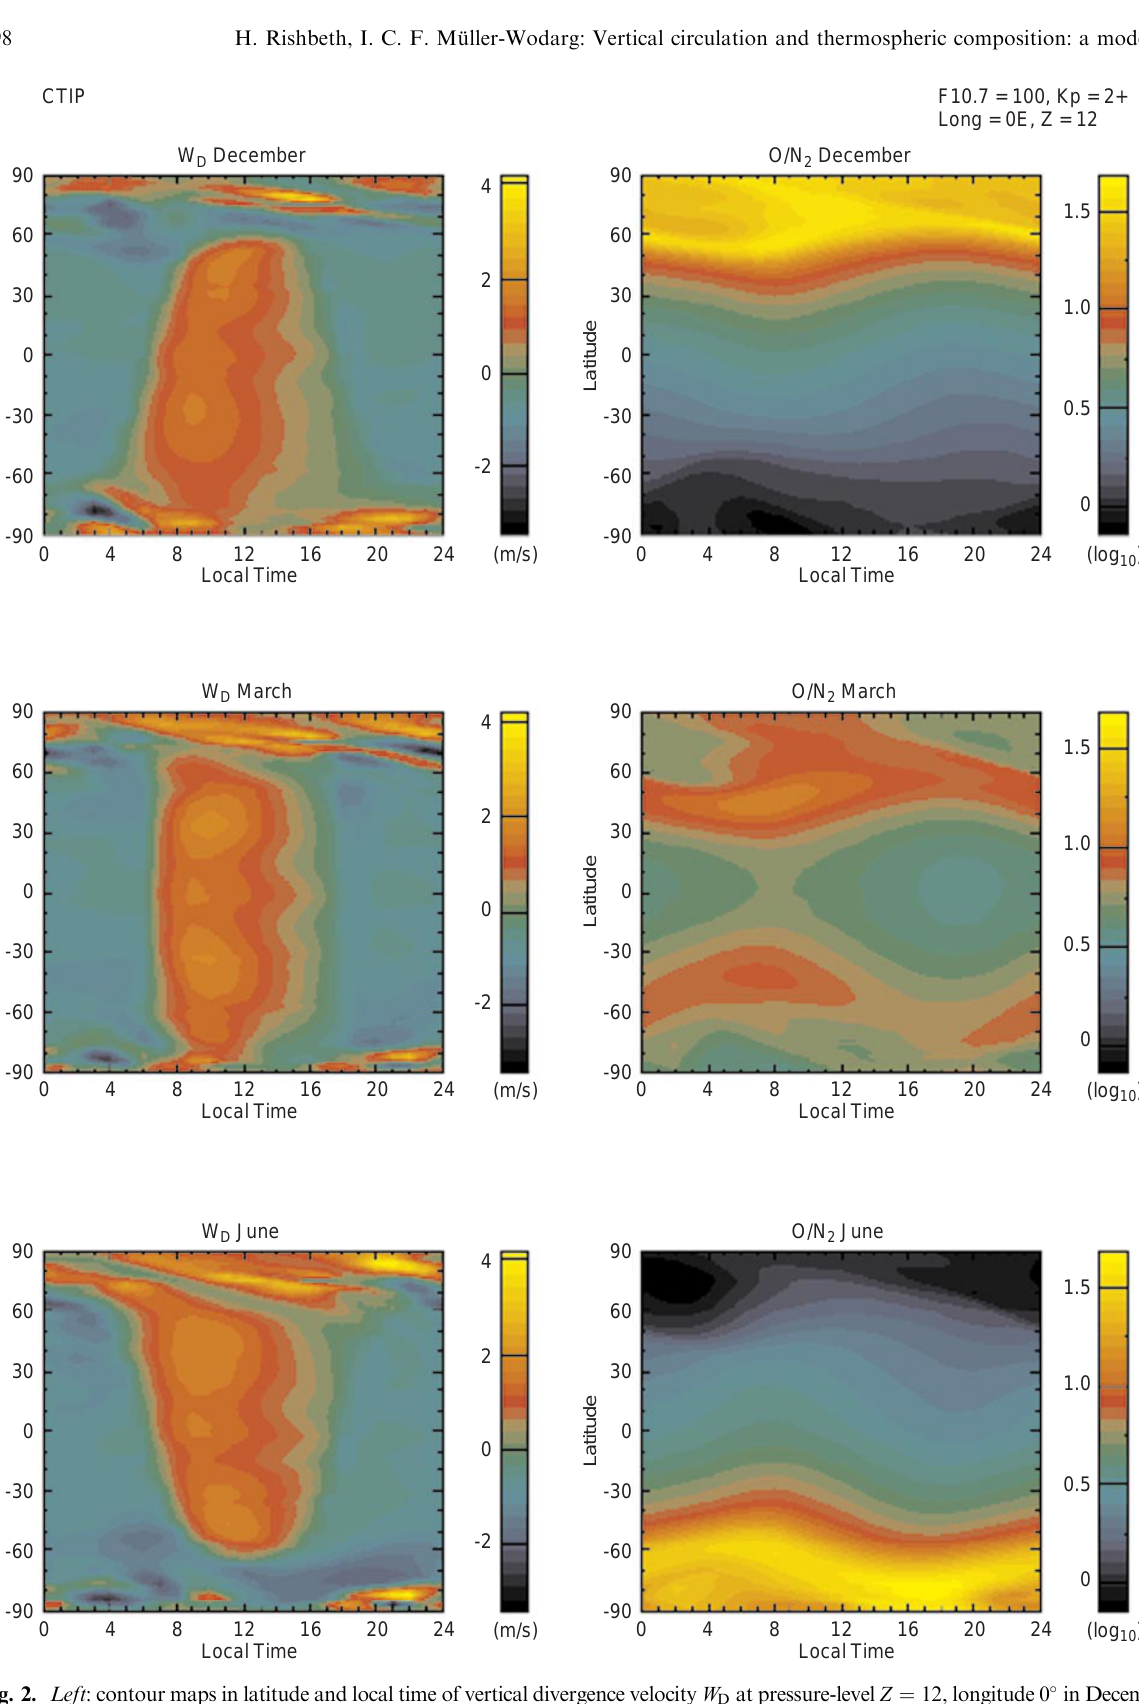
Fig. 2. Left : contour maps in latitude and local time of vertical divergence velocity W D at pressure-level Z (cid:136) 12, longitude 0 (cid:14) in December, March and June. Right : contour maps in latitude and local time of (cid:137) O = N 2 (cid:138) ratio at pressure-level Z (cid:136) 12, longitude 0 (cid:14) in December, March